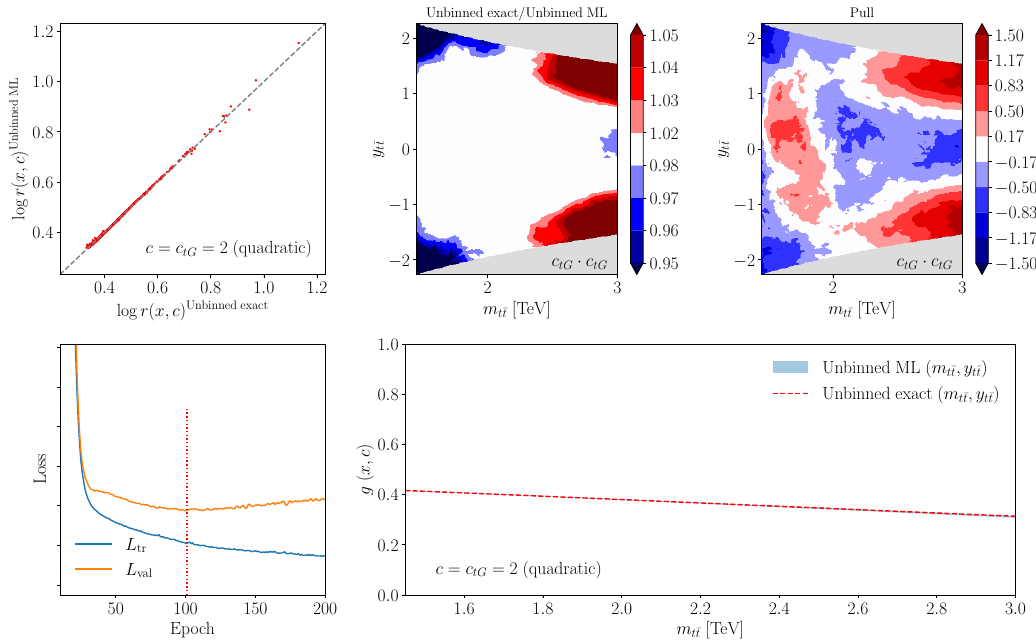
Figure 1. Validation of the machine learning parametrization of the EFT cross-section ratios when applied to the case of parton-level top quark pair production to be described in section 4. The results shown here correspond to the training of the quadratic neural network NN ( j,j ) ( m in eq. (3.19) with j indicating the chromomagnetic operator c tG . From left to right and top to bottom we display a point-by-point comparison of the log-likelihood ratio in the ML model and the corresponding analytical calculation; the median of the ratio between the ML model and the analytical calculation and the associated pull in the ( m loss function split in training and validation sets for a representative replica as a function of the number of training epochs; and the resultant decision boundary g ( x, c ) for c tG = 2 including MC replica uncertainties at the end of the training